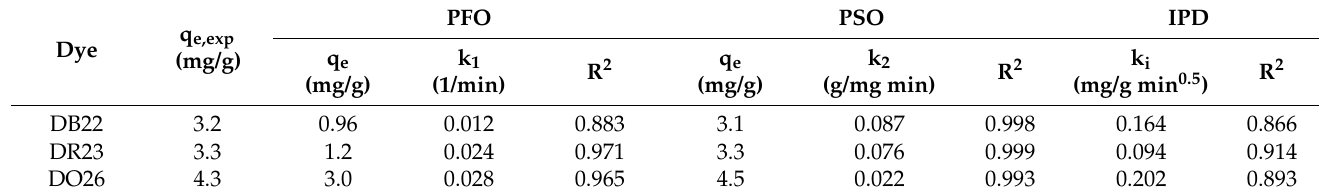
Table 4. Kinetic parameters calculated from PFO, PSO and IPD models for direct dye sorption on A21 resin in aqueous solutions of 100 mg/L initial